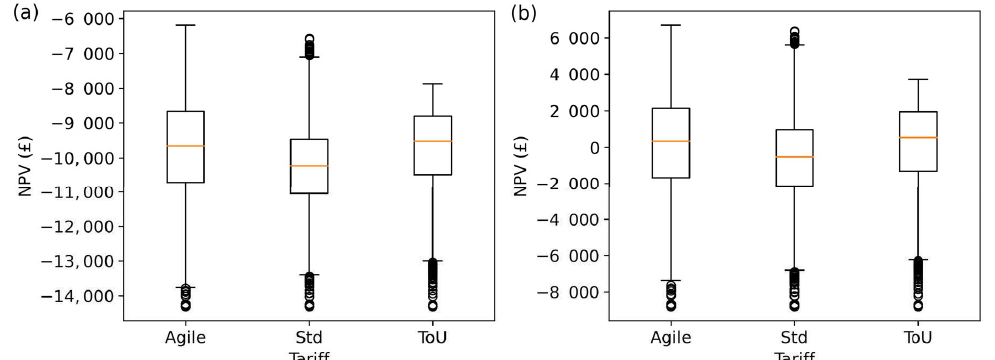
Figure 6. Boxplots of the distribution of NPVs for the fixed PV + BES configuration for all consumers under all tariffs. ( a ) The NPV distributions under the baseline cost scenario. ( b ) The NPV distributions under the future cost scenario. The median of the distribution is shown by the horizontal